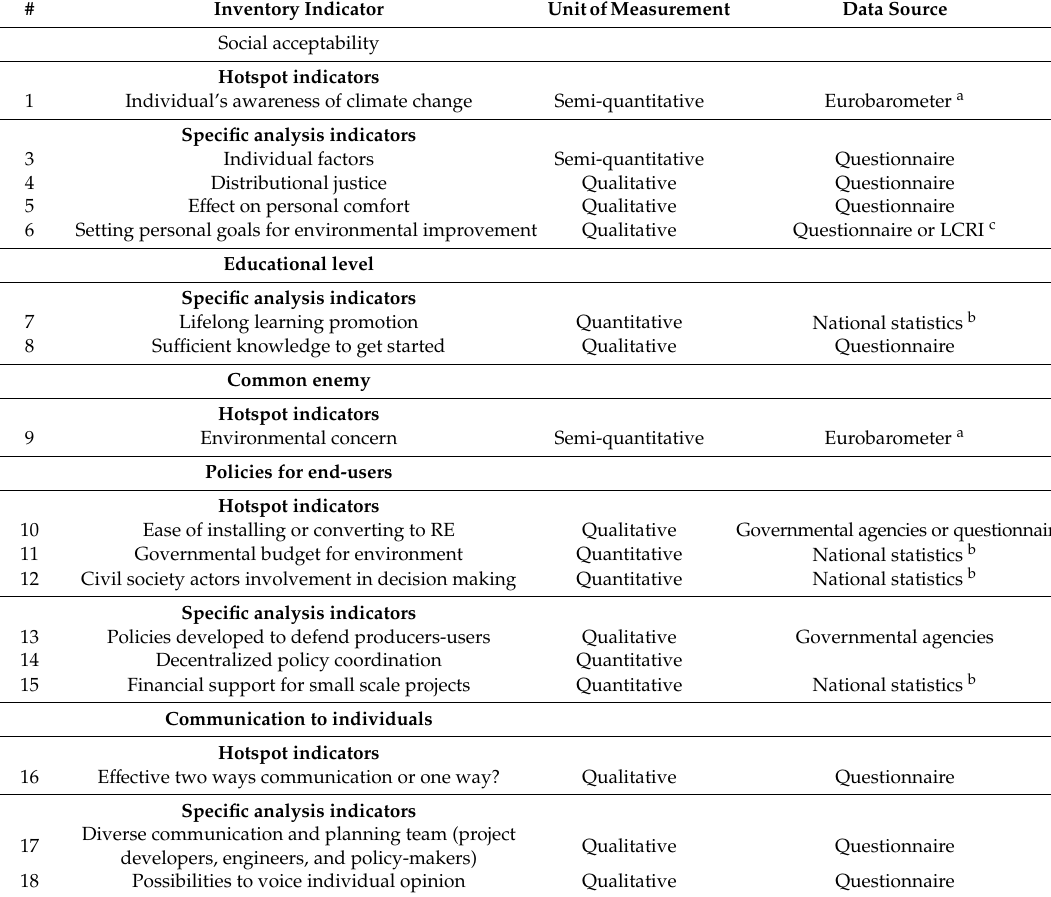
Table 3. Prosumer’s subcategories and indicators.